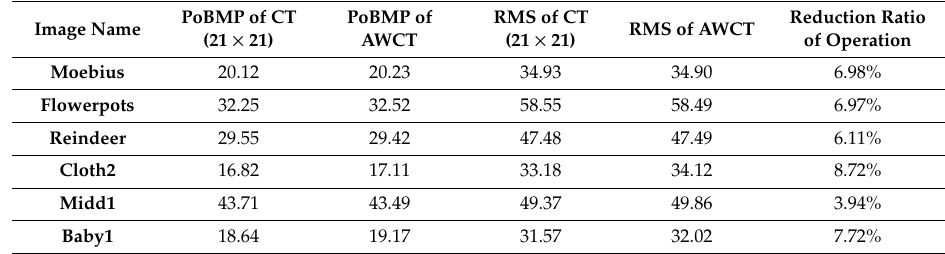
Table 2. Comparison of AWCT and CT.